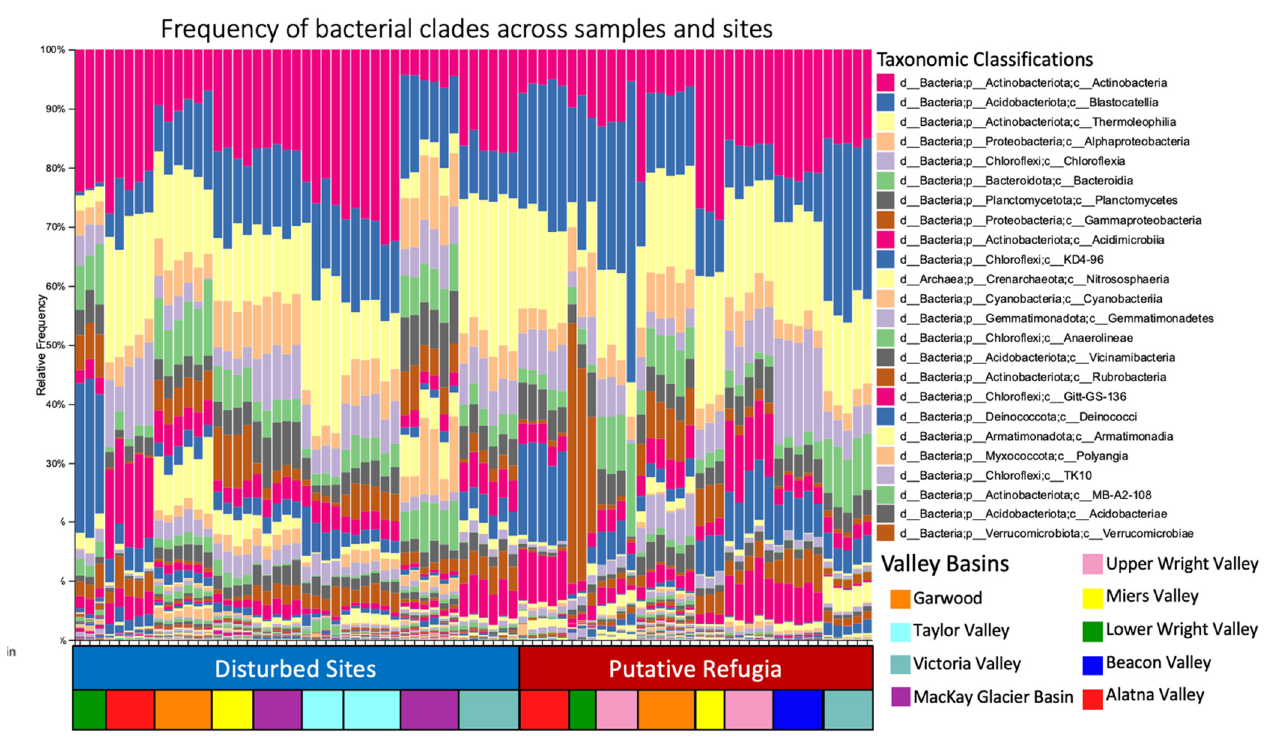
Figure 2. Frequency of bacterial and archaeal clades across samples. Relative frequency of ASVs in each sample is displayed at the class level; the vertical axis shows the proportion of total ASVs in each sample for each class. The horizontal axis is coloured to show if a sample originated from a site characterized as a disturbed site or putative refugia. Colors represent the valley basin of sample origin.